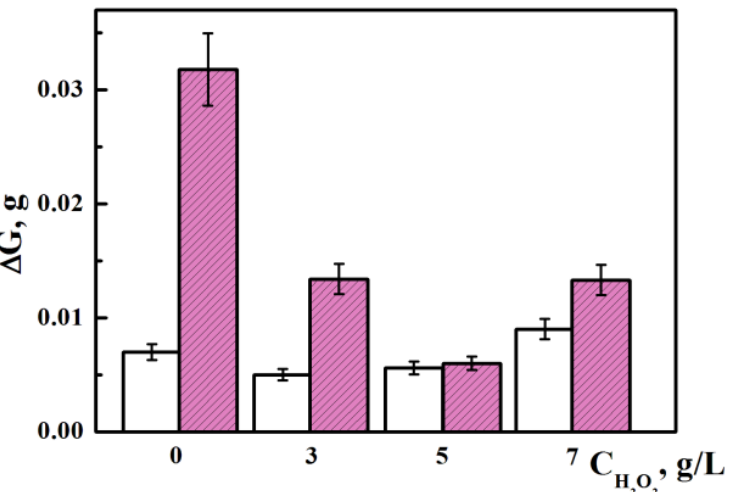
Figure 17. Influence of the content of hydrogen peroxide C H2O2 in the basic electrolyte on the weight loss ∆ G of PEO layers on the surfaces of the AK-9 (white bars) and AK12 (dark bars) alloys during wear resistance tests with a fixed abrasive.